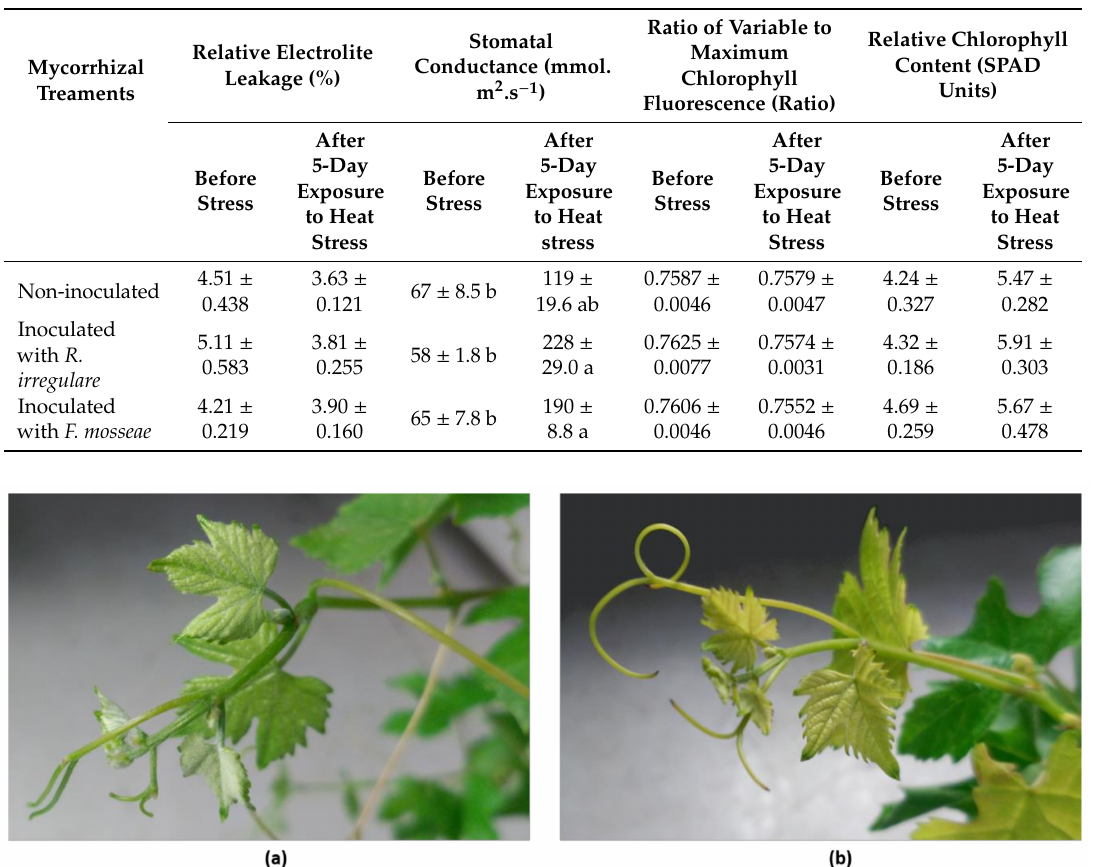
Figure 4. Apical leaves of a ‘Touriga Nacional’ grapevine plant. ( a ) Before plant exposure to 5 days of heat stress; ( b ) After plant exposure to heat stress for 5